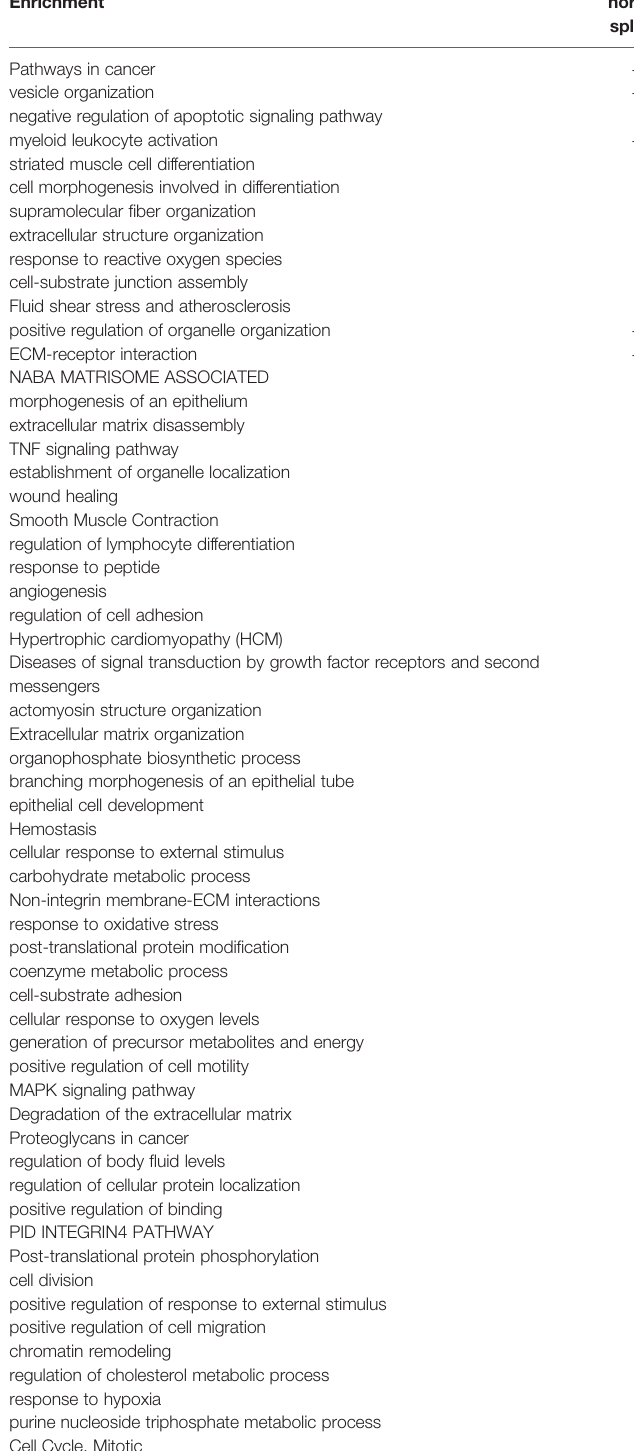
TABLE 3E | Metascape analysis was performed to identify pathways associated with upregulated caspase-1 dependent GSDMD secretome gene lists in various Treg groups.